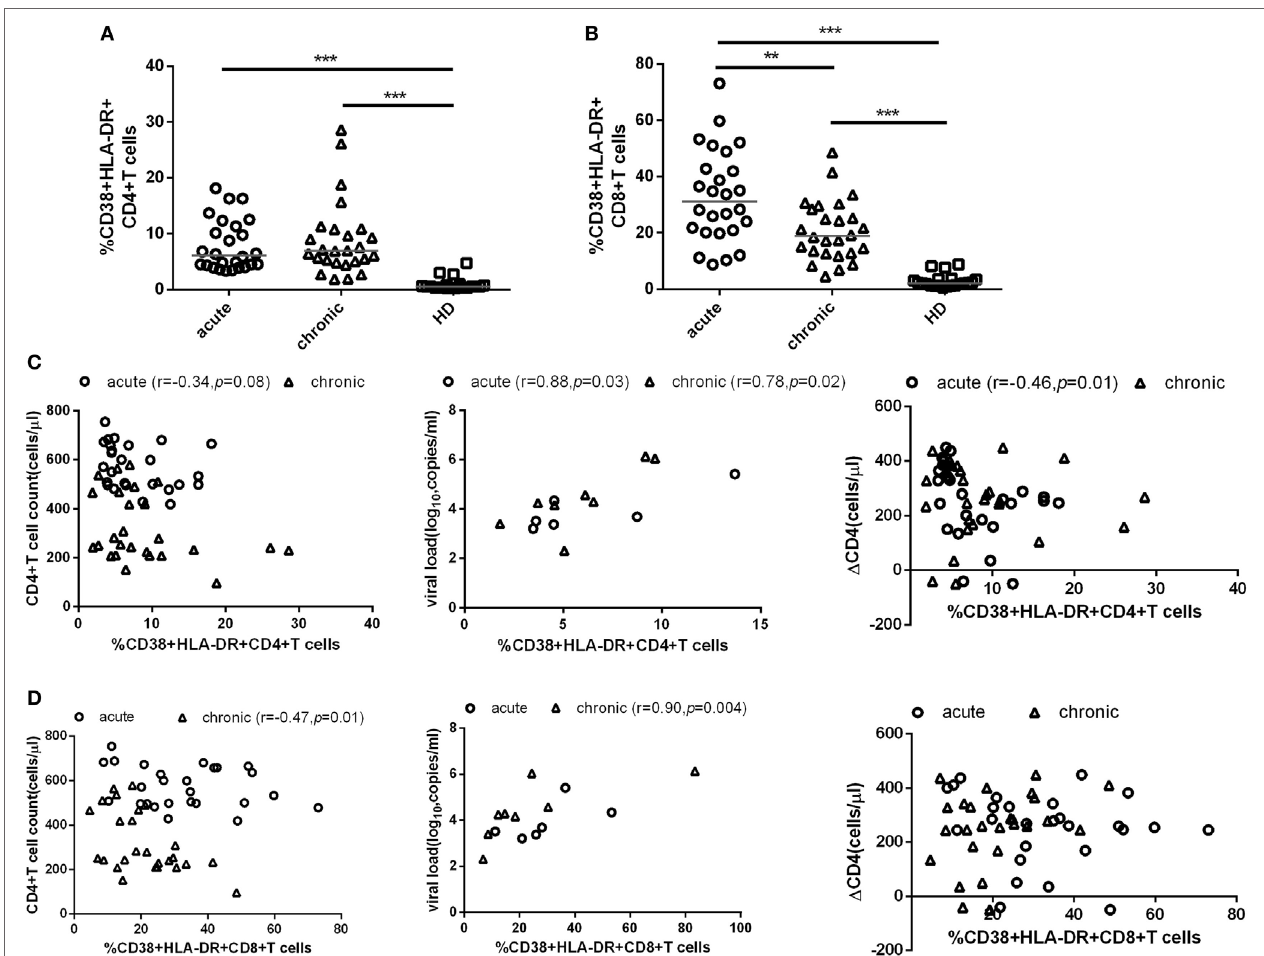
FigUre 1 | CD4 + and CD8 + T cell activation in HIV-1 acute and chronic infection stage. Comparisons of the level of CD4 + T (a) and CD8 + T (b) cell immune activation among healthy donors (HDs, □ ), HIV-1 acute (AHIs, ○ ) and chronic (chronic HIV-1 infection stage, Δ ) infection stage. (c) Correlation between CD4 + T cell immune activation and CD4 + T cell count ( left ), viral load ( middle ), and CD4 + T cell depletion from acute stage to observation end-point in chronic stage ( Δ CD4, right ). (D) Correlation between CD8 + T cell immune activation and CD4 + T cell count ( left ), viral load ( middle ), and Δ CD4 ( right ). Significance of difference was calculated by Mann–Whitney U test. Correlation analysis was performed by Spearman’s rank test. Horizontal lines indicate median values (* p < 0.05, ** p < 0.01, *** p <